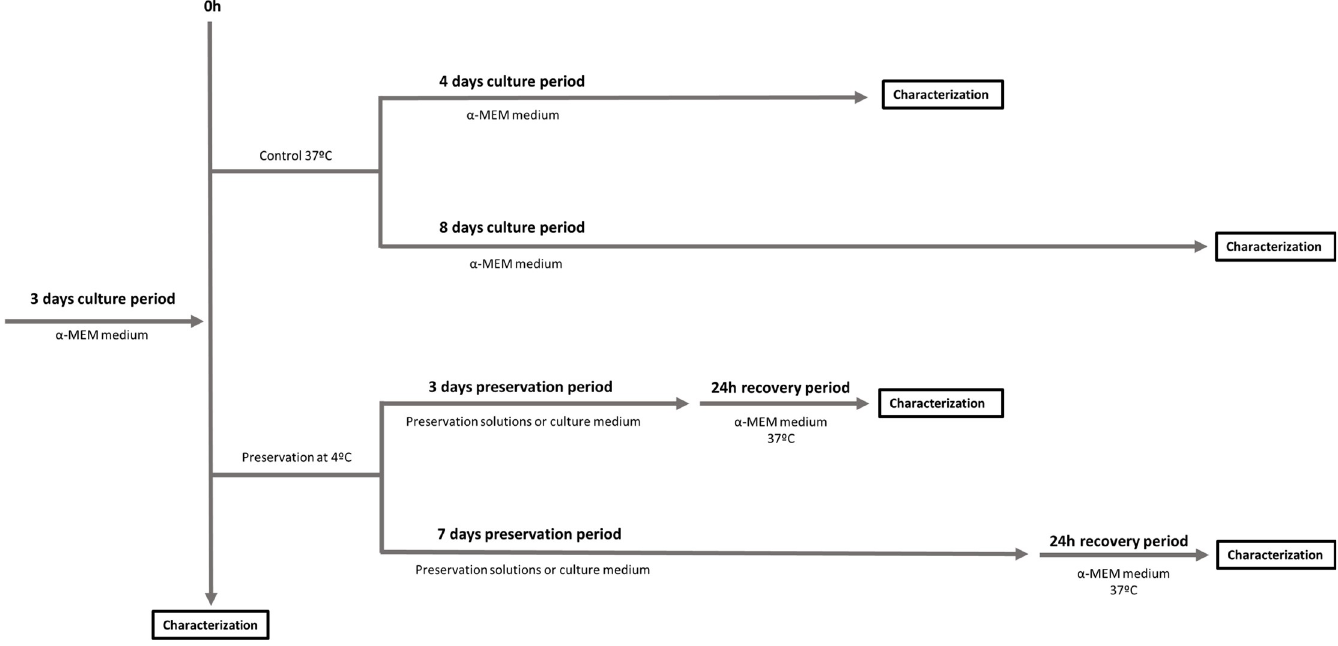
Fig 1. Schematic overview of the overall methodology followed along the